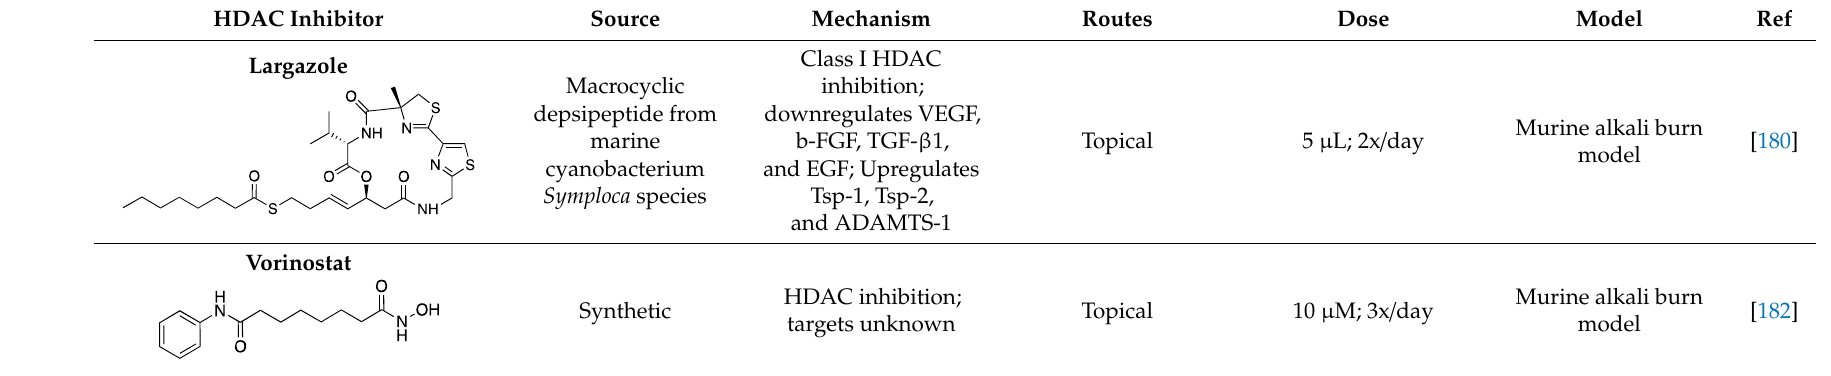
Table 8. HDAC inhibitors tested in CoNV models.